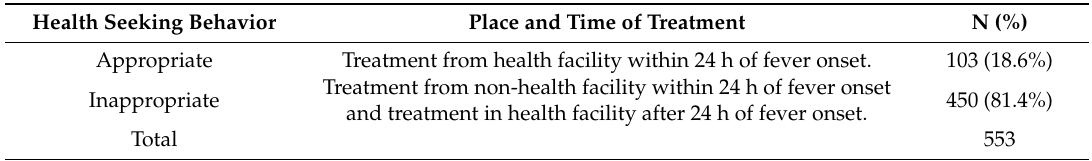
Table 3. Characteristics of appropriate and inappropriate HSB.